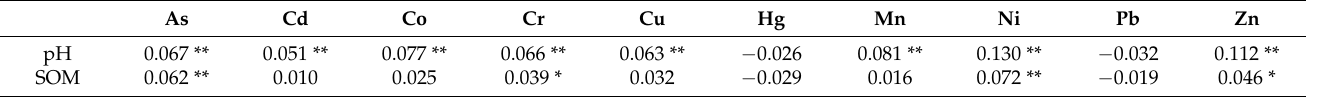
Figure 4. Correlation analysis among soil heavy metals. Table 3. Correlation analysis of soil heavy metals with pH and SOM.